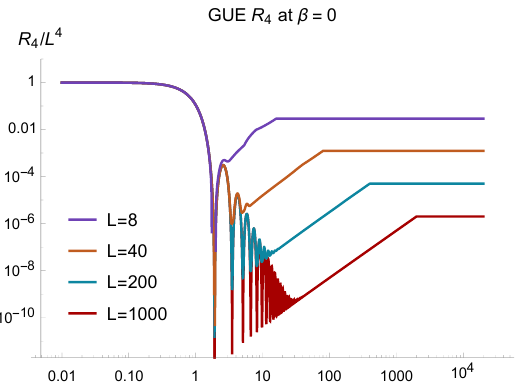
Figure 4 . The GUE 4-point spectral form factor at in(cid:12)nite temperature, plotted for di(cid:11)erent values of L and normalized by their initial values. We observe the scaling of the dip and plateau, and the quadratic rise (cid:24) t 2